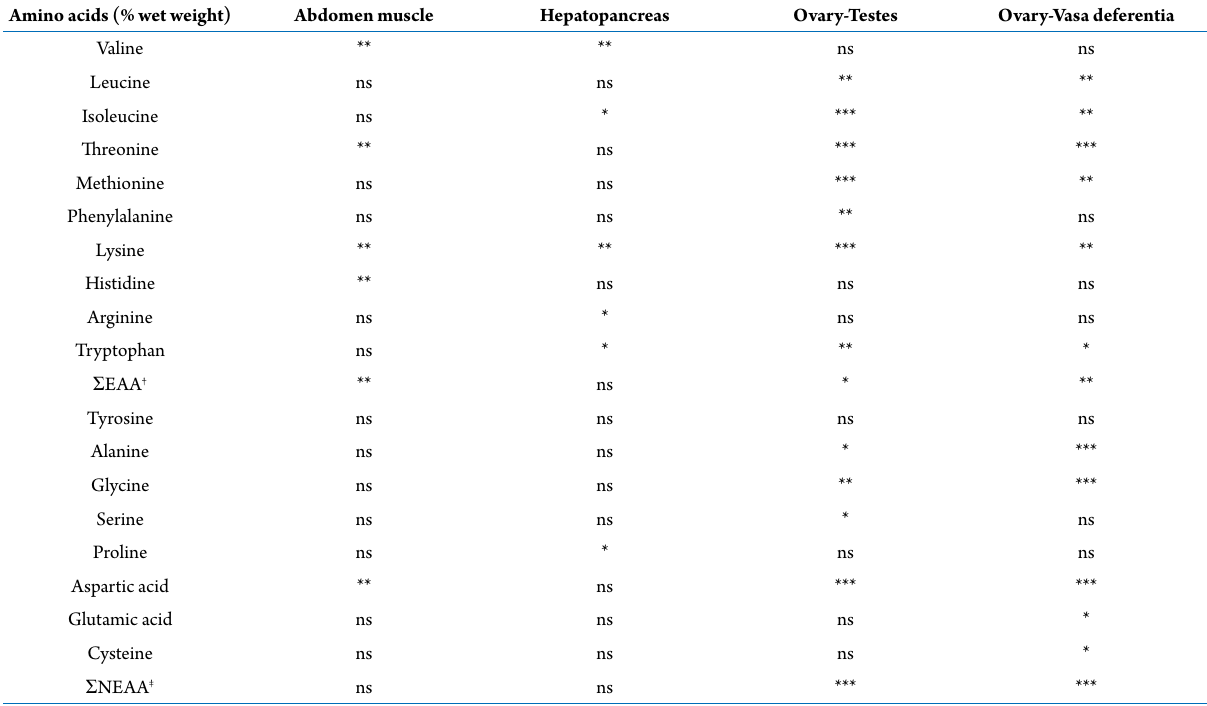
Table 4. Statistical comparison of amino acid concentration (%, wet weight) in abdomen muscle, hepatopancreas, ovary-testes, ovary-vasa deferentia between male and female Pontastacus leptodactylus. Amino acids (% wet